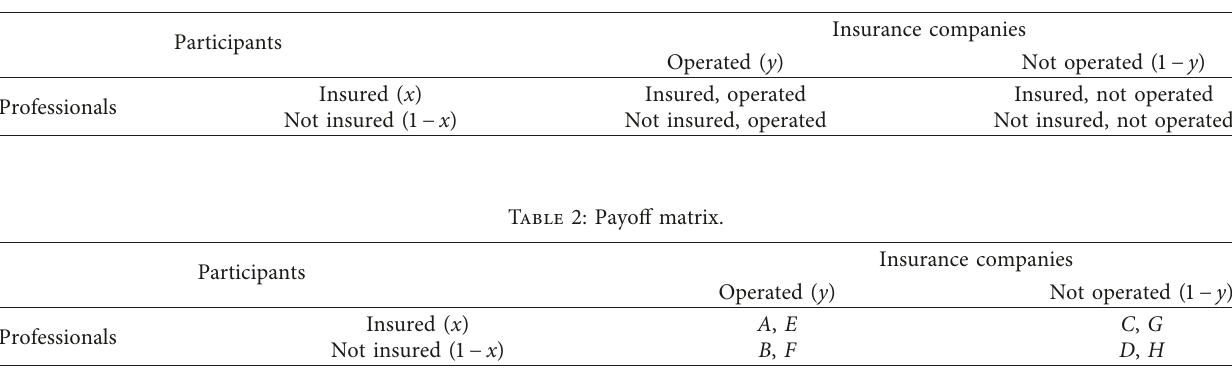
Table 1: Game strategy matrix.